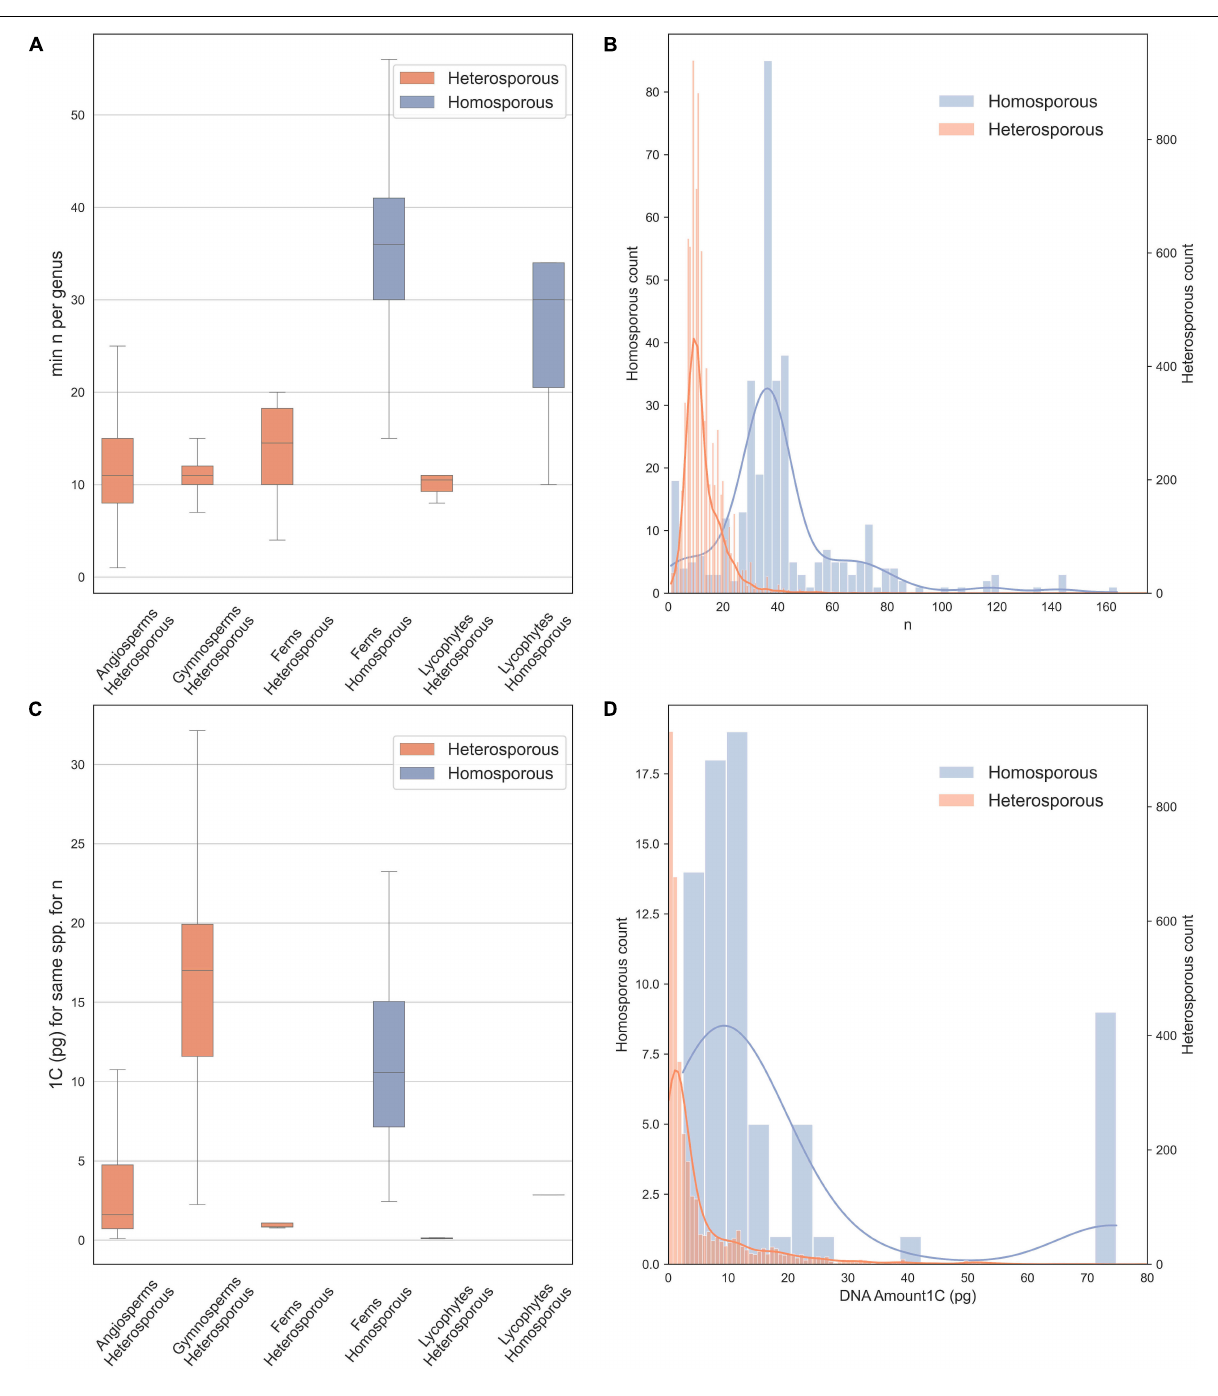
FIGURE 1 | Chromosome counts and genome sizes for heterosporous and homosporous plant clades. Data were downloaded in January 2021 from the Chromosome Counts Database version 1.47 (Rice et al., 2015) and the Plant DNA C -values Database (Pellicer and Leitch, 2020). (A) Boxplots of chromosome counts ( n = 7,900), including only the minimum reported count for a genus, boxes are central two quartiles and whiskers are interquartile range × 1.5 (data from Rice et al., 2015). (B) Histogram with kernel density plot of chromosome counts for homosporous plants (blue, right y -axis; mean n = 42.25) and heterosporous plants (orange, left y -axis; mean n = 12.74)—note scales are different to account for unequal sample size. (C) Boxplots of genome size estimates (1C), included are all possible minimum values for each species. (D) Histogram with kernel density plot of genome size estimates for homosporous plants (blue, right y -axis; mean 1C = 12.52) and heterosporous plants (orange, left y -axis; mean 1C = 6.43), on different